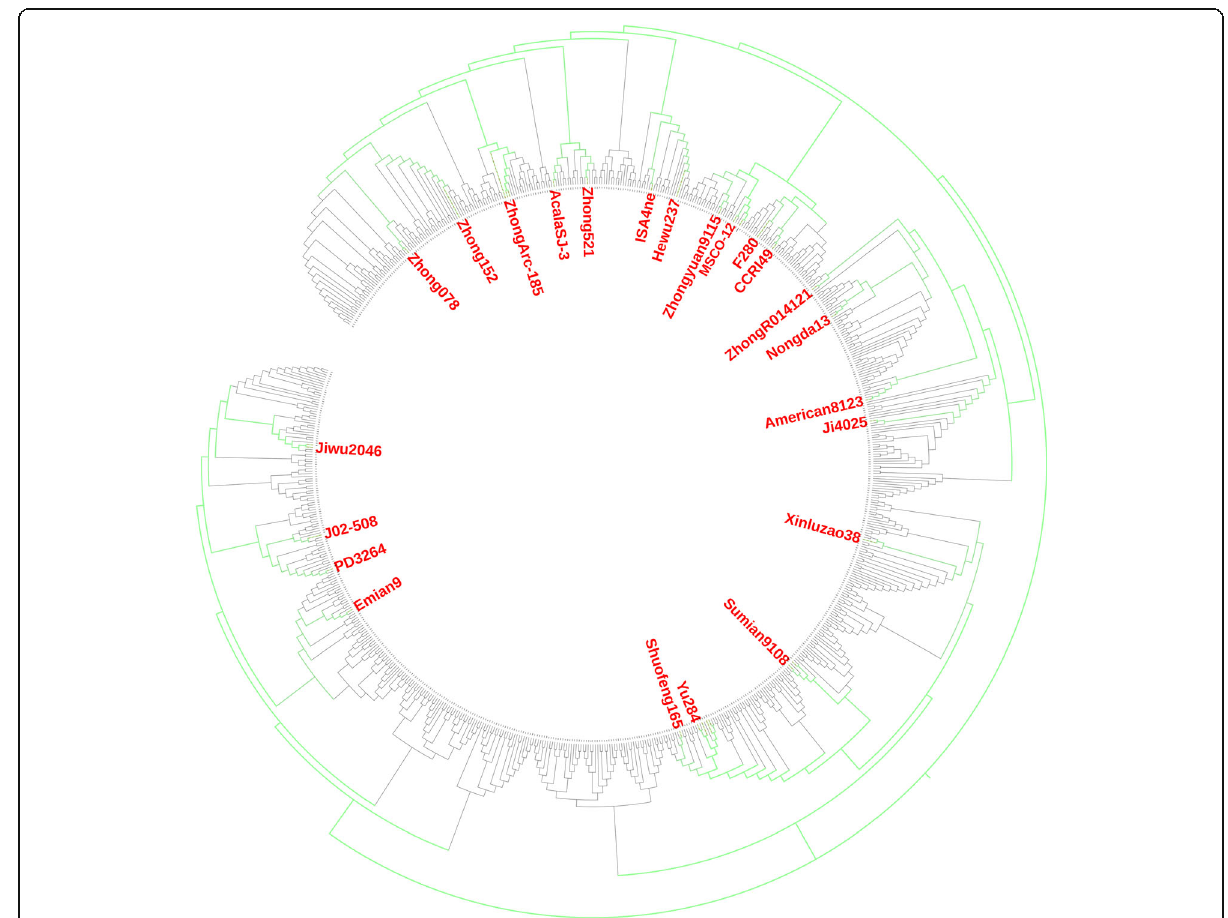
Fig. 4 Phylogenetic relationship of 719 upland cotton genotypes using SNP